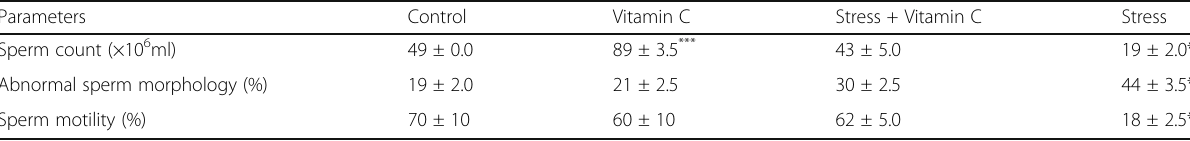
Table 2 Table showing the effect of chronic variable stress with vitamin C supplementation on sperm parameters